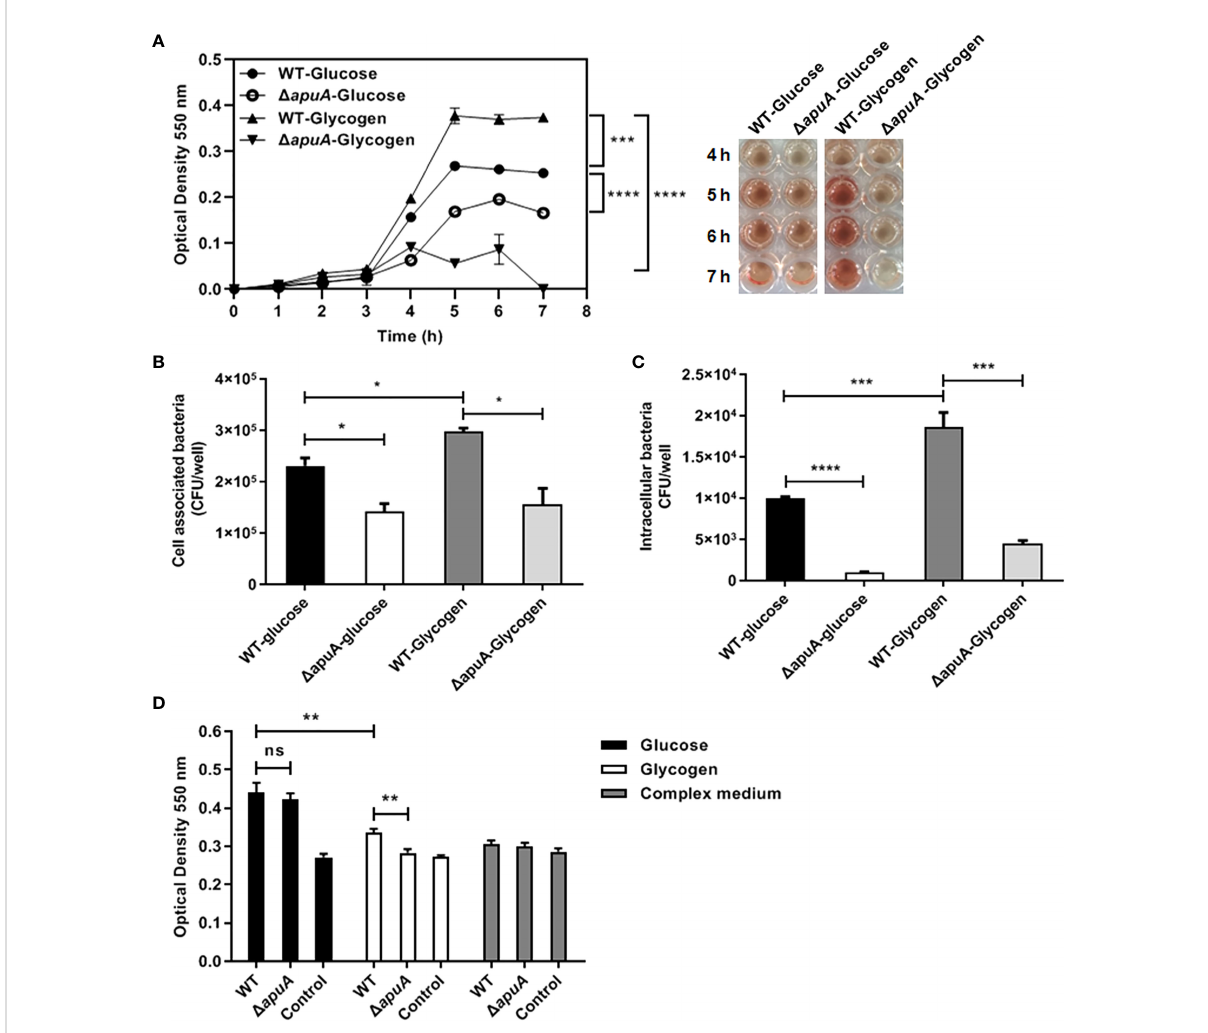
FIGURE 7 Pathogenic assays of WT and D apuA in the presence of different medium. (A) Hemolysis assay. Hemolysis production was quanti fi ed by analyzing the supernatants collected from WT and D apuA supplemented with glucose and glycogen. The absorbance at each hour at stable period (5, 6, and 7 h) was recorded and analyzed by pairwise comparison. (B) Cell-associated bacteria recovered after incubation with NPTr cells. (C) Pathogen invasion of NPTr cells. Extracellular bacteria were eradicated through antibiotic treatment. (D) Bio fi lm formation assay. The wells with a sterile medium and CM served as negative controls. Data points or columns are presented as mean ± SEM from three independent experiments performed in triplicate. Statistical signi fi cance was determined using the two-tailed t-test (ns, P > 0.05; *, P < 0.05; **, P < 0.01; ***, P < 0.001; ****, P <